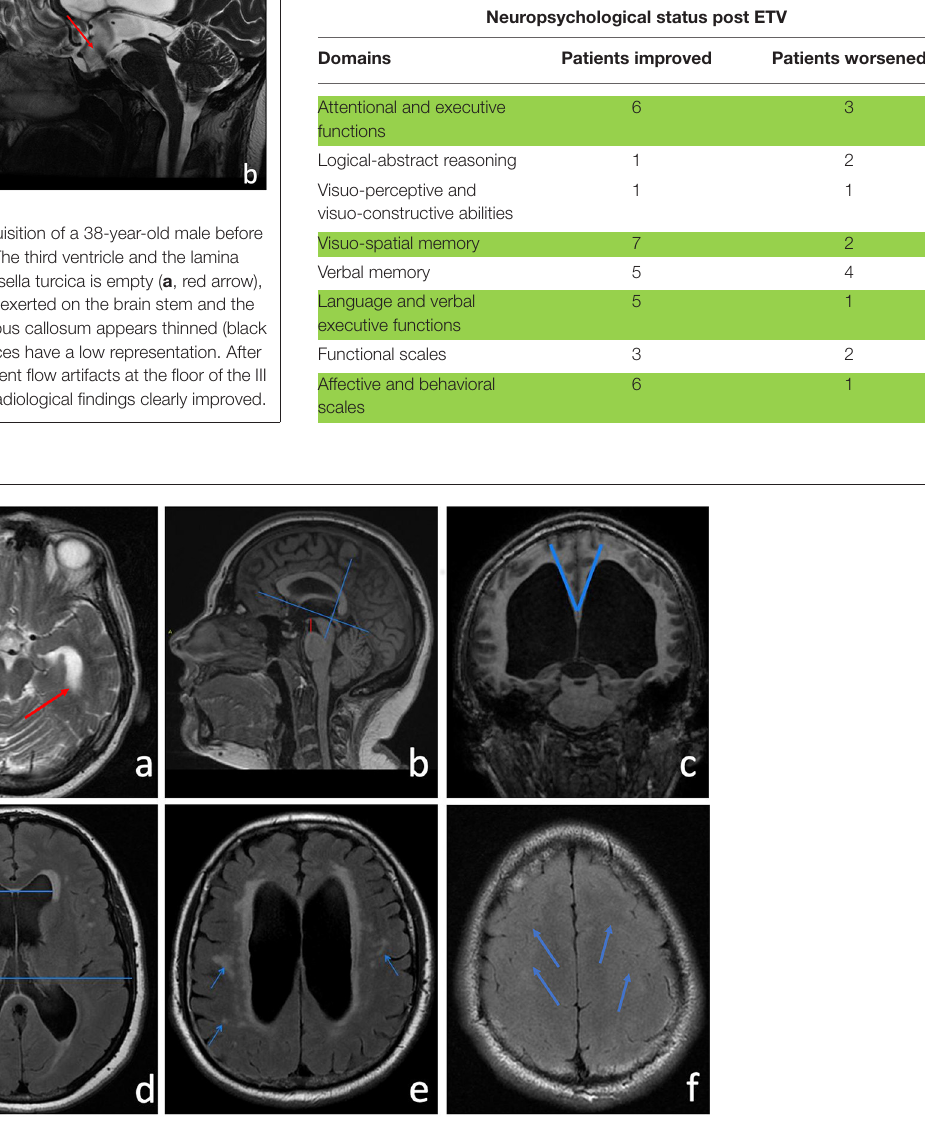
FIGURE 2 | (a) Axial T2-w showing a clear enlargement of the temporal horns (red arrows). (b) Sagittal 3D MPRAGE T1-w was used to measure the height of the interpeduncular cistern, which represents the shortest distance between the floor of the third ventricle and the midbrain (a red line). After identifying the AC-PC plane, the callosal angle (c) is measured in the coronal plane through the posterior commissure perpendicular to the anterior commissure-posterior commissure (AC-PC) plane. Neuroradiological features of LIAS mimic iNPH also for CA amplitude that usually measures < 90 ◦ . (d) Evan’s index (EI) is a direct linear measurement of the ventricular size. It is calculated from the ratio between the maximum transverse diameter of the frontal horns and the maximum internal diameter of the skull. (e) The FLAIR sequence shows an elevated periventricular signal ascribable to interstitial edema or reactive gliosis. Hyperintense white matter lesions attributed to chronic ischemia of the small vessels are indicated by the arrows. (f) Narrowed sulci at the high cerebral convexities (blue arrows).